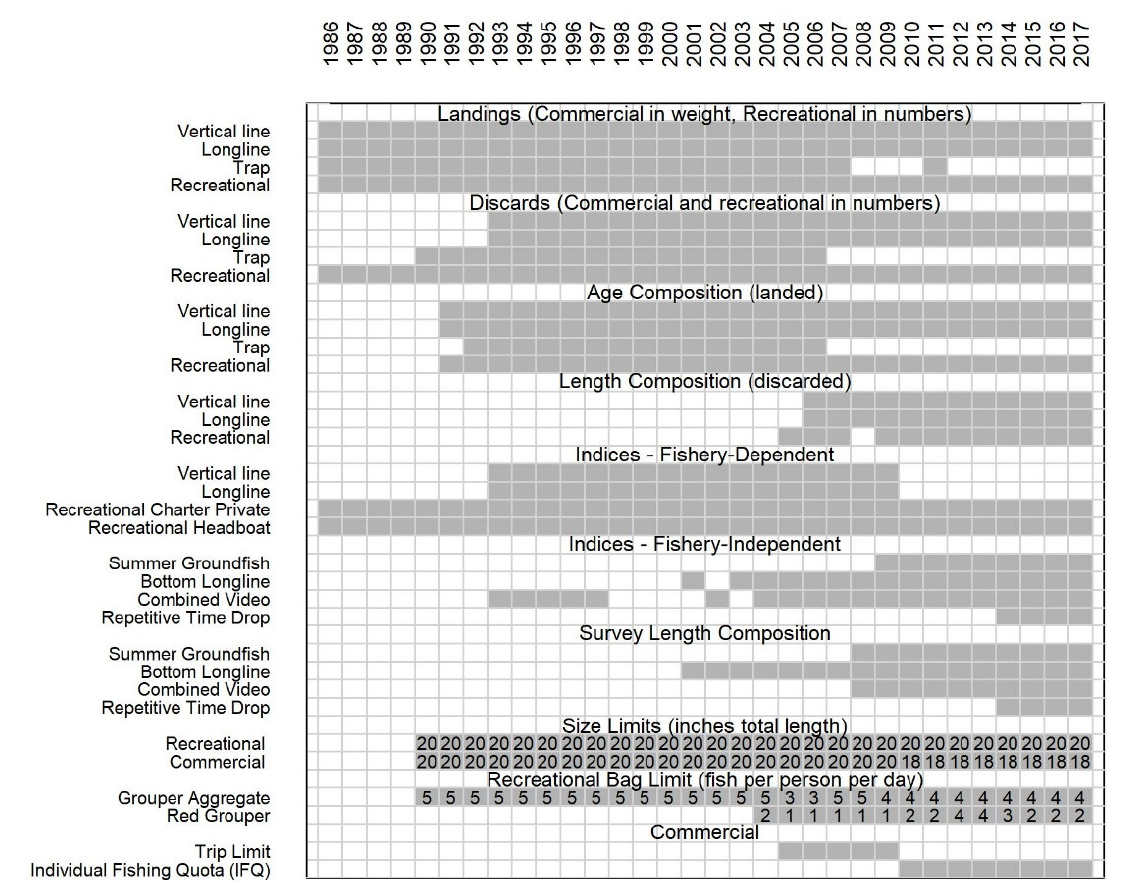
Figure 2. Time series of data inputs incorporated into the Gulf red grouper stock assessment model and relevant management regulations (with values specified where necessary).